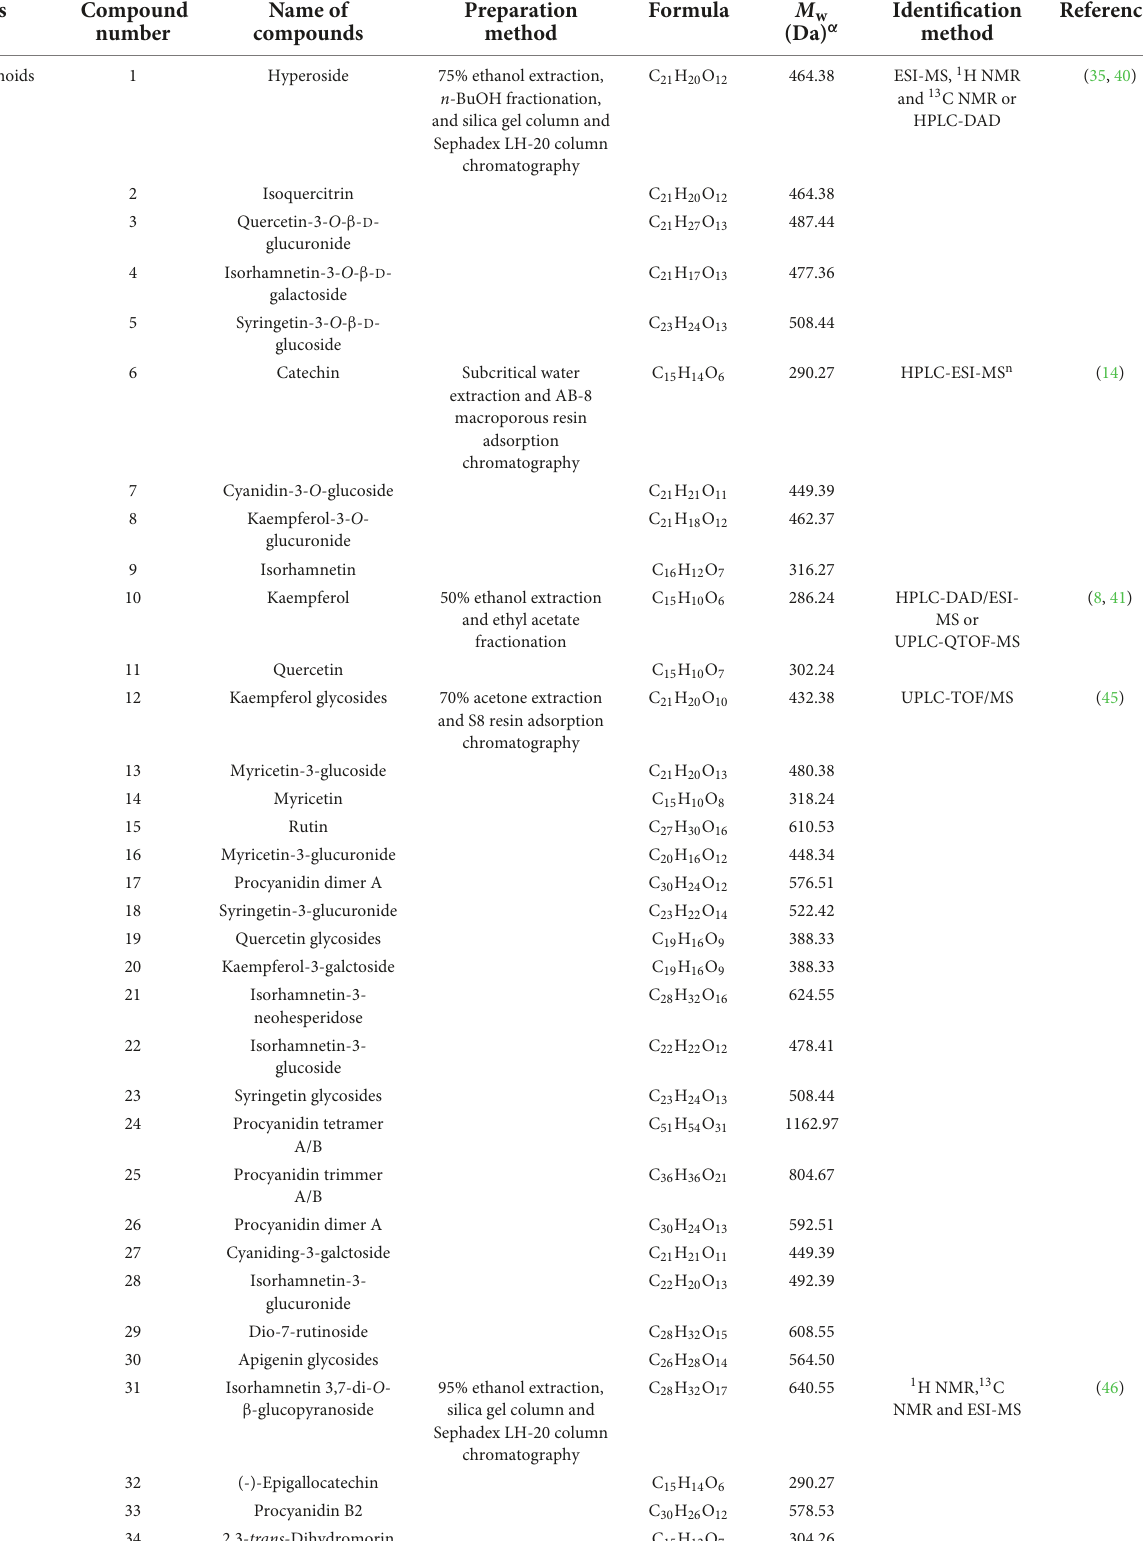
TABLE 1 Some identified compounds from lotus seedpods (Receptaculum Nelumbinis)